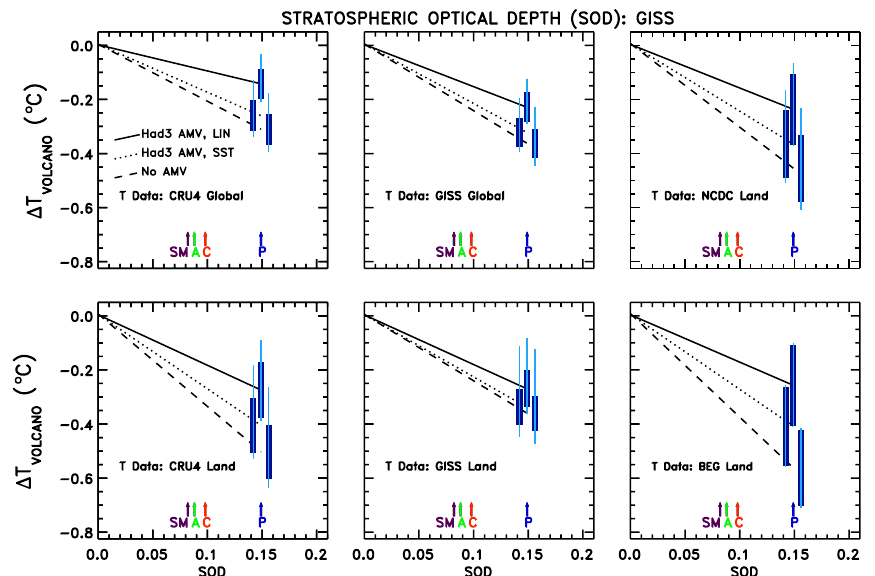
Fig. 12. Cooling attributed to volcanoes ( 1T VOLCANO ) as a function of stratospheric optical depth (SOD), for regression of monthly mean global temperature anomalies ( 1T ) from various data centers, as indicated (after “ T Data:”). The black lines each represent C 1 × SOD versus SOD, where C 1 is the volcanic regression coefficient. Results for no AMV (solid lines), AMV Had3 LIN (dotted), and AMV Had3 SST (dashed), assuming NAA RF 2005 = − 1 . 0Wm − 2 along the “Middle Road” of Fig. 4, are shown for each panel. Maximum SOD associated with the eruptions of Santa Mar´ıa, Mount Agung, El Chich´on and Mt. Pinatubo from Sato et al. (1993) are denoted on each panel by the coloured arrows marked SM, A, C and P. The thick dark blue vertical error bars denote the 95% confidence interval of the volcanic regression coefficient (C 1 , Eq. (2)). The thin blue lines are a root sum of squares combination of the statistical uncertainty and the variation in C 1 due to uncertainty in NAA RF 2005 (see text). All regressions begin at January 1900. The end date is driven by availability of data. Regressions using data from GISS and NCDC extend to December 2011, regressions using data from CRU4 extend to December 2010, and the regression using data from BEG runs to May